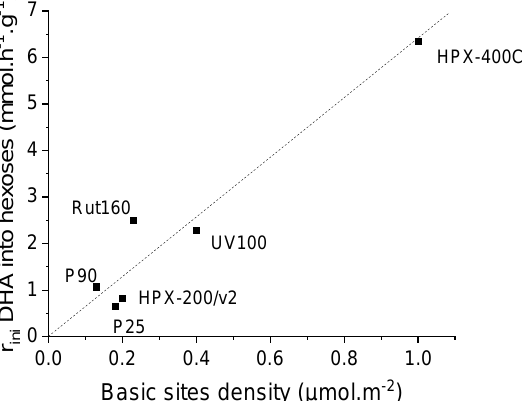
(cid:48) s basic sites